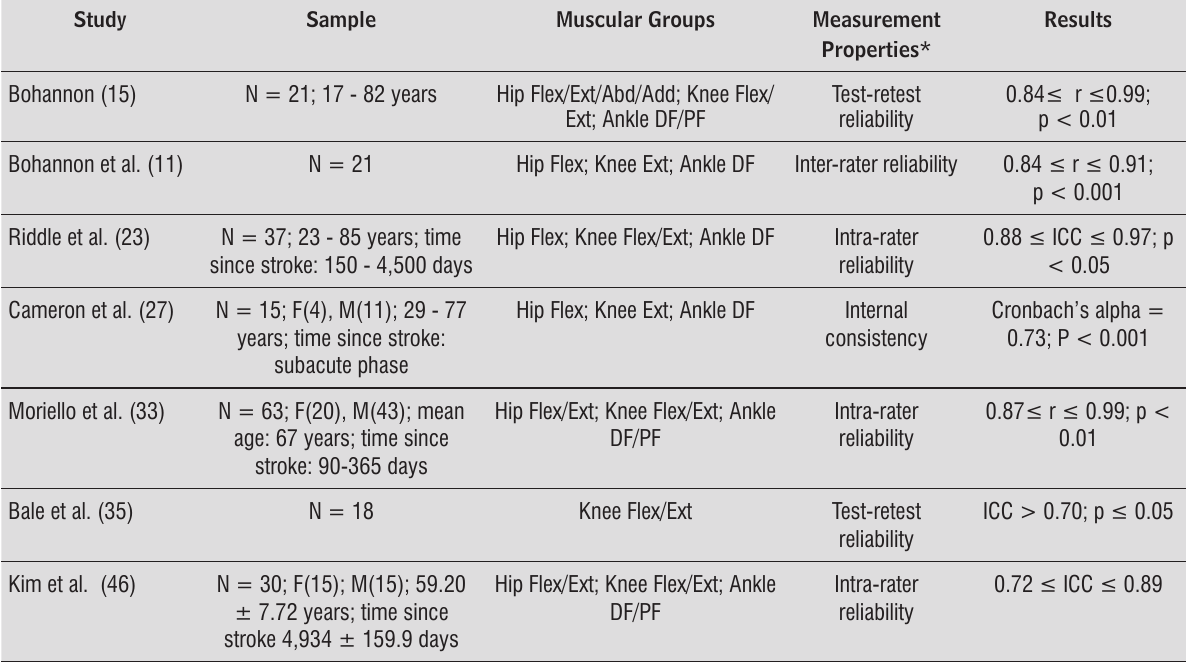
Table 3 - Results of the seven studies which assessed the measurement properties of portable dynamometry Study